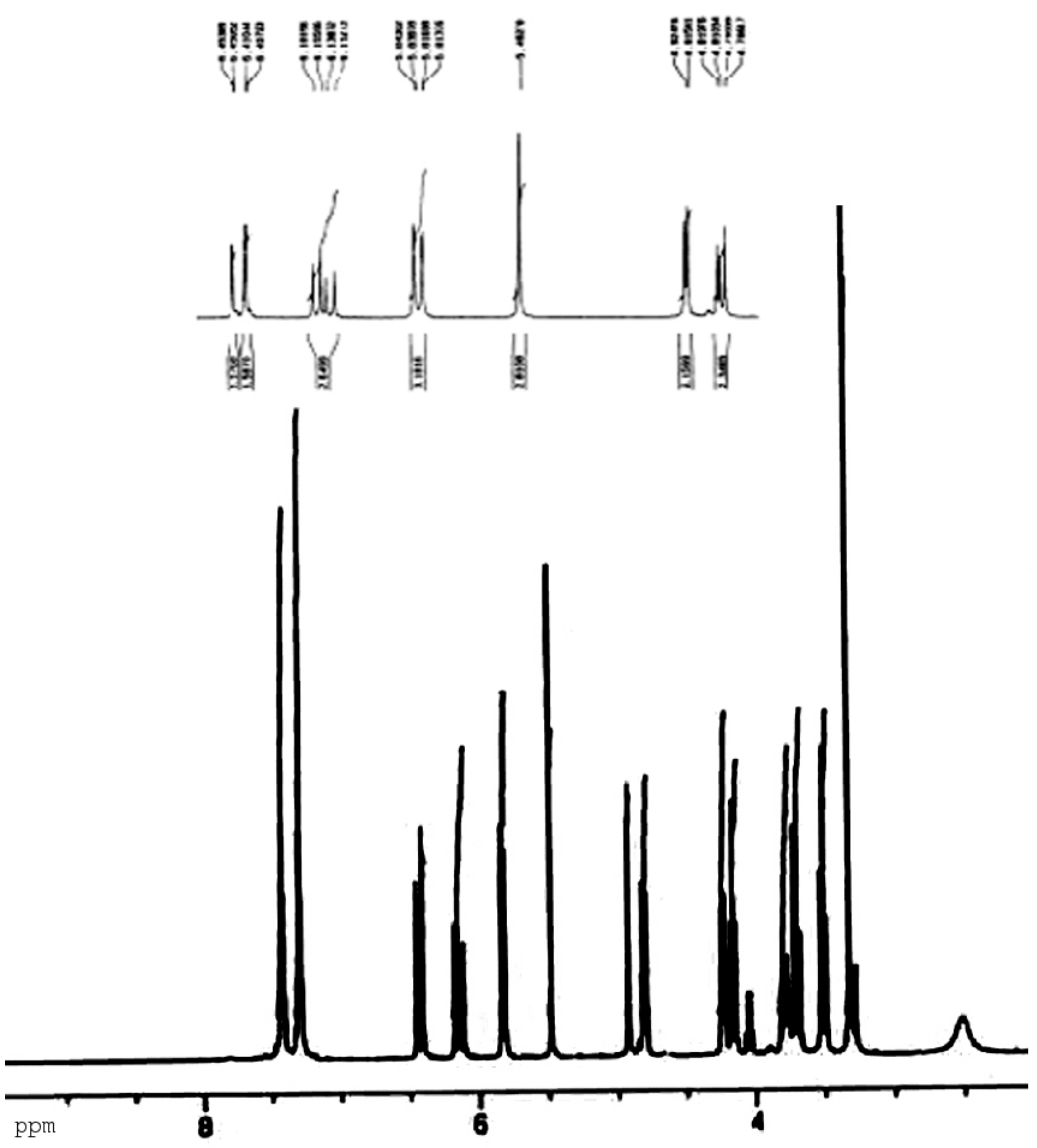
Figure 1 : 400 MHz 1 H-NMR of methyl 4,6- O -benzylidene-2- O -acryloyl- α -D-gluco- pyranoside ( 1a ) in CDCl